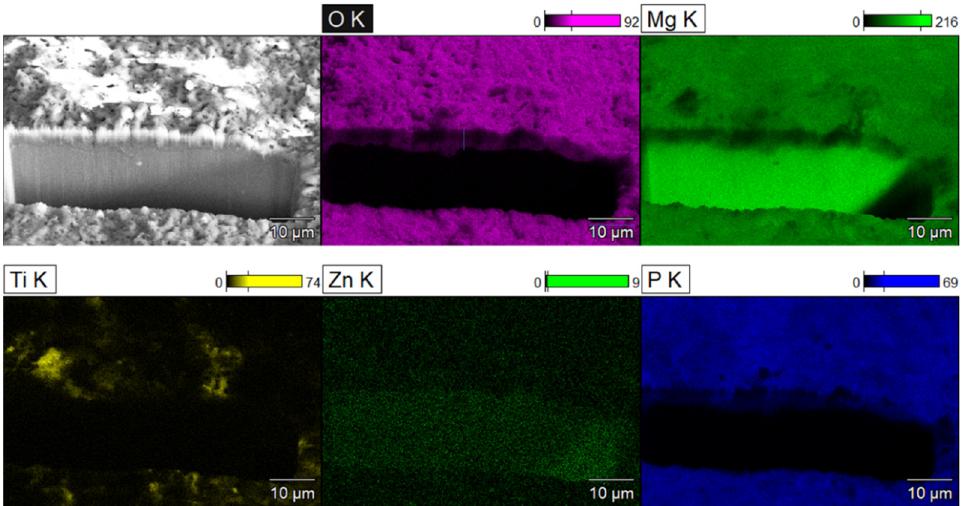
Figure 4. SEM depicting the SEM-FIB cross-section of PEO coating along with the EDS maps of various elements.